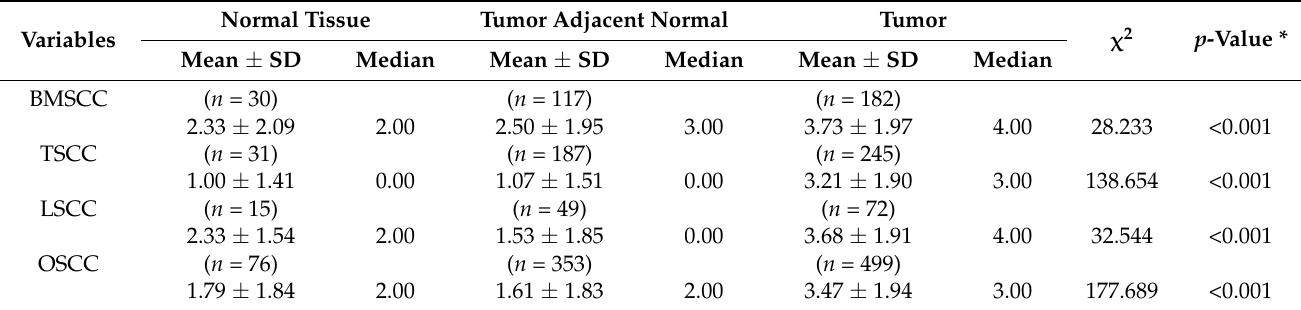
Table 1. The comparison of GBP5 expression in the three different tissues of BMSCC, TSCC, LSCC, and OSCC patients.